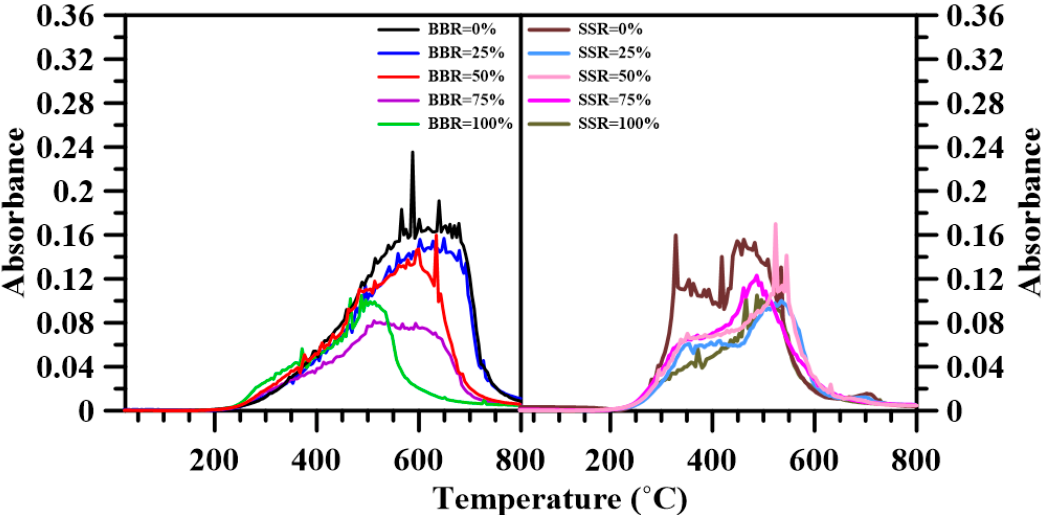
Figure 12. Evolution of CO 2 for various sludge-coal and sludge-shiitake ratios in TGA-FTIR.